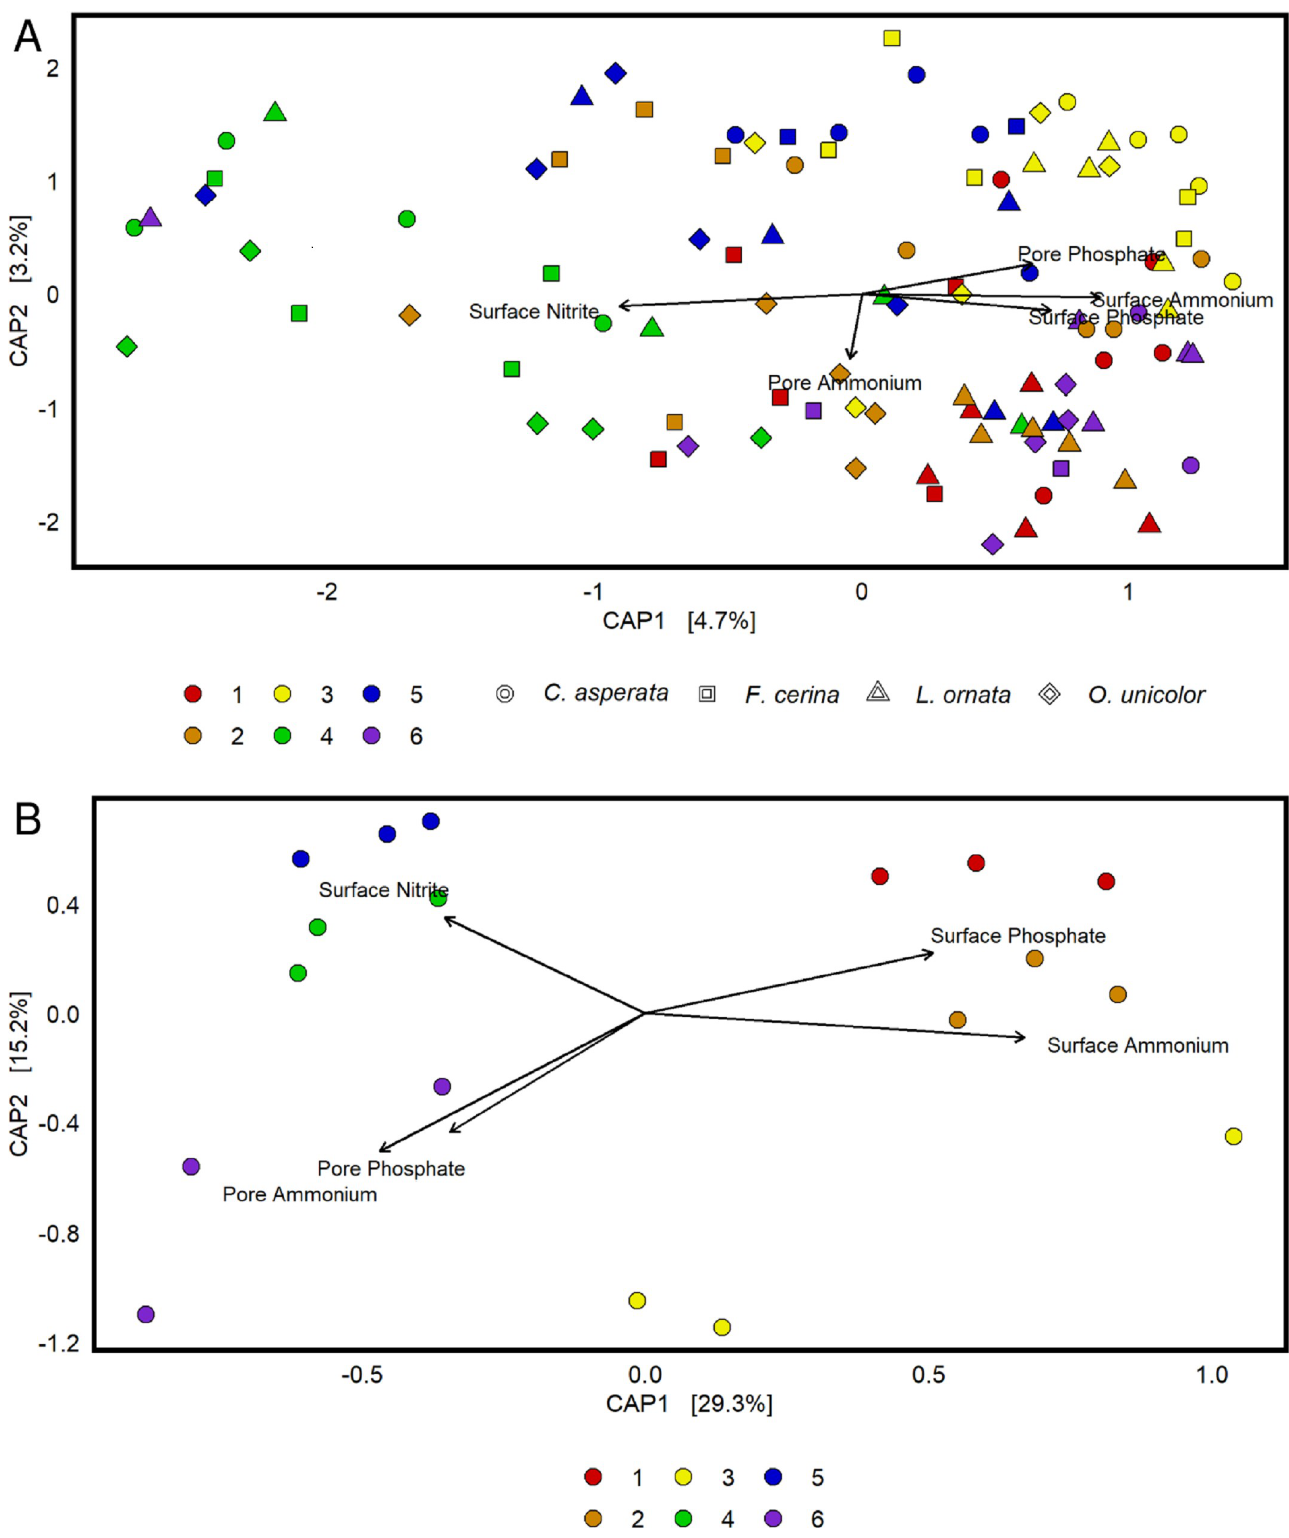
Fig 6. A constrained principal coordinates analysis (CAP) of 16S rRNA bacterial microbiome data collected from the mussel species Cyclonaias asperata , Fusconaia cerina , Lampsilis ornata , and Obovaria unicolor as well as seston from the Sipsey River, AL, USA. Bray-Curtis dissimilarity was used to separate